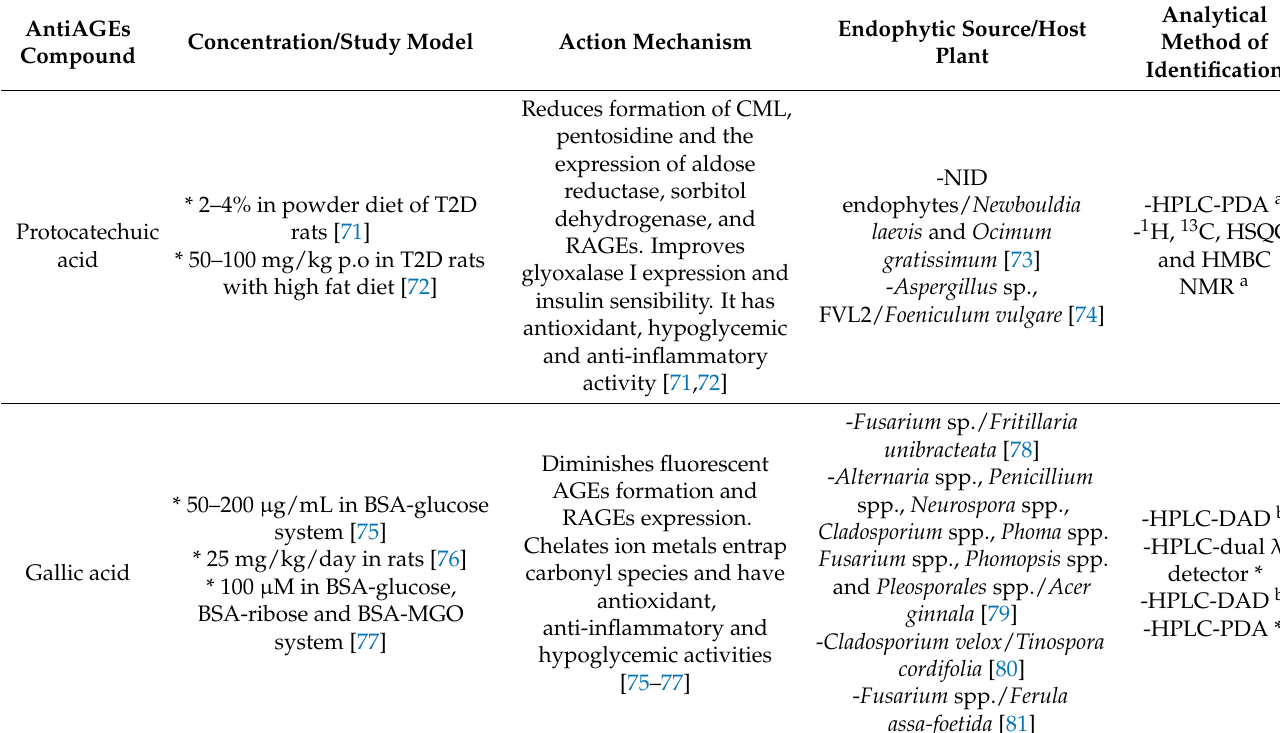
Table 1. Anti-AGE compounds reported as metabolites synthesized by